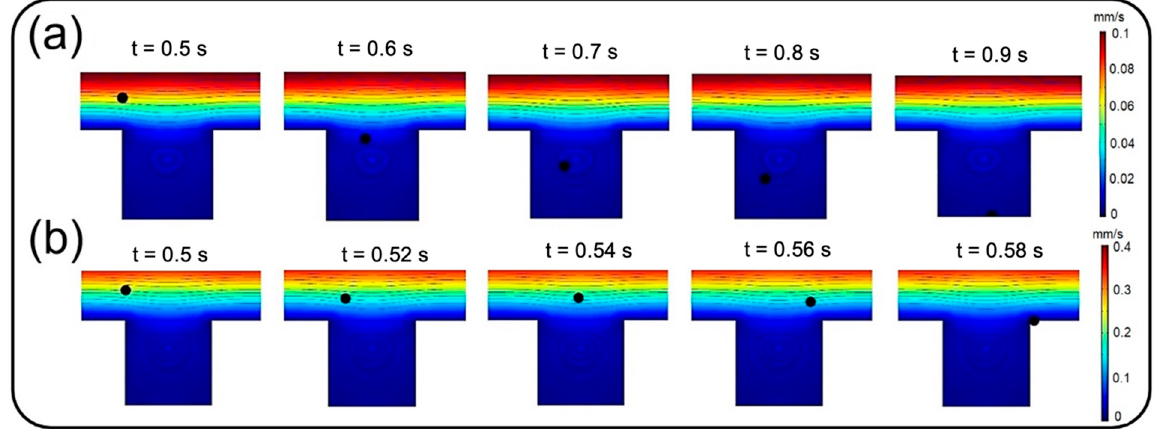
Figure 9. Trajectory of an initially inert 900 nm particle in the porous region for inflow velocities of ( a ) 0.3 mm/s and ( b ) 1 mm/s.